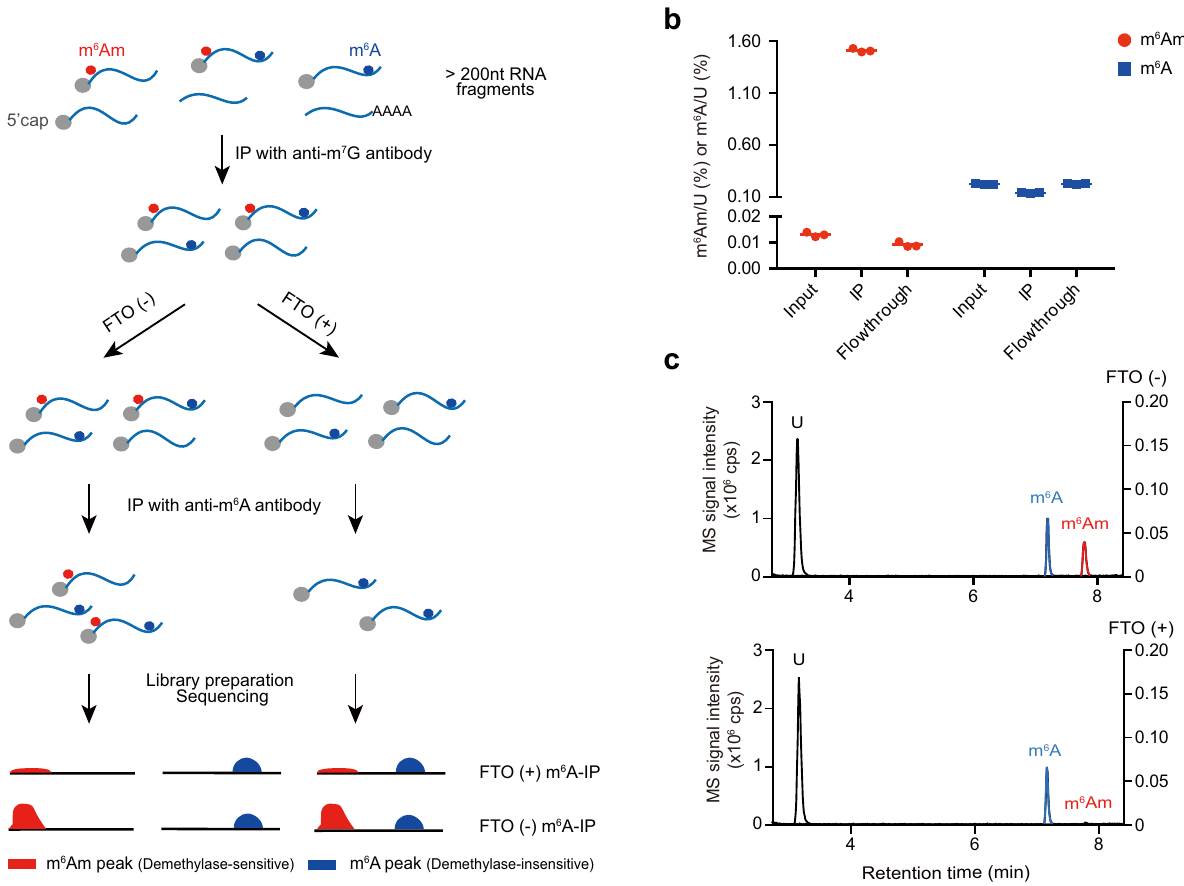
Fig. 1 m 6 Am-seq combines RNA immunoprecipitation with an optimized demethylation reaction to enrich and distinguish m 6 Am and 5 ′ -UTR m 6 A. a Scheme of m 6 Am-seq. Total RNA (>200 nt) was fragmented (input) and immunoprecipitated with cap-m 7 G antibody (m 7 G-IP). The cap structure- containing RNA was subjected to [FTO ( + )] or [FTO ( − )] treatment. The [FTO ( + )] or [FTO ( − )] samples were immunoprecipitated with an m 6 A antibody and sequenced for m 6 Am detection. The sequencing pro fi les of the [FTO ( + ) m 6 A-IP] and [FTO ( − ) m 6 A-IP] samples were normalized and compared. The “ Demethylase-sensitive peaks ” and “ Demethylase-insensitive peaks ” were identi fi ed. The demethylase-sensitive peaks bear the m 6 Am, while the demethylase-insensitive peaks bear the m 6 A (Online Methods). b The m 6 Am and m 6 A levels of input, m 7 G-IP, and fl owthrough samples were quanti fi ed by LC – MS/MS, respectively. m 6 Am was signi fi cantly enriched (>100 fold) by cap-m 7 G antibody while m 6 A level decreased mildly. Values represent mean ± SD ( n = 3 independent samples in “ Input ” , “ IP ” and “ Flowthrough ” respectively). c The m 6 Am and m 6 A levels of [FTO ( + )] and [FTO ( − )] samples were quanti fi ed by LC – MS/MS, respectively. >95% m 6 Am was demethylated and m 6 A was negligibly altered under optimized demethylation conditions. The chromatograms of U (black) and m 6 Am (red) are scaled to the left Y axis, and the chromatograms of m 6 A (blue) are scaled to the right Y axis. Source data are provided as a Source Data fi